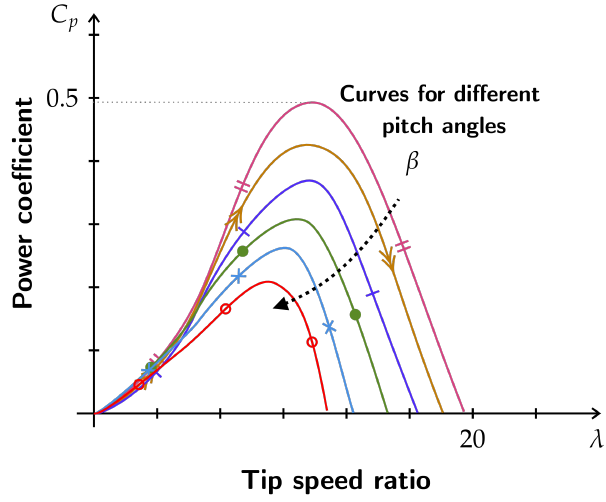
Figure 2. Power coefficient with respect to the pitch angle and tip speed ratio C p ( λ , β )